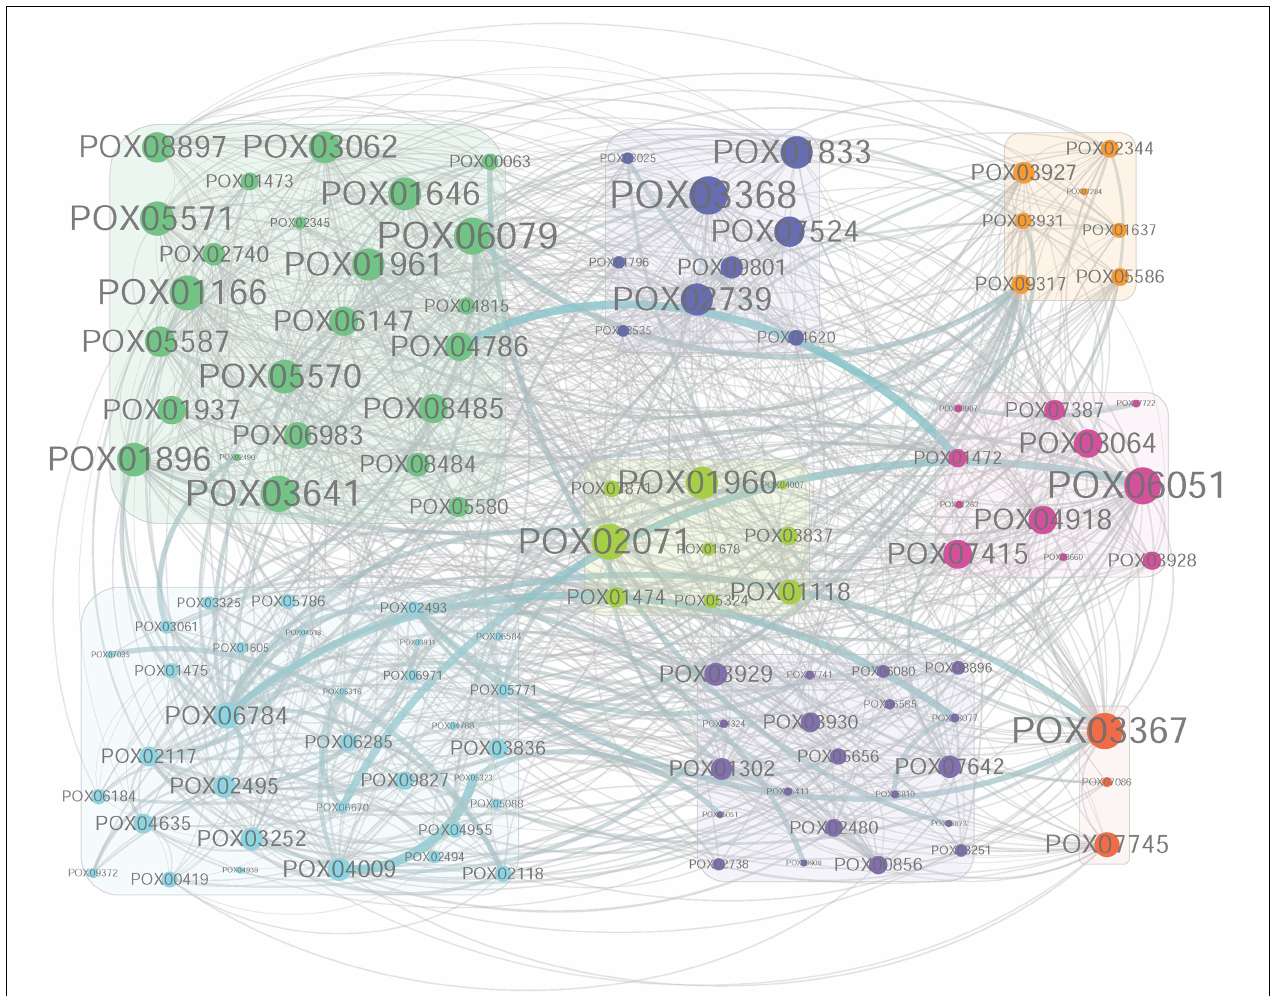
FIGURE 11 | Co-expression network of the highly connected genes in module MEivory. The co-expression network of genes in MEivory was constructed using Cytoscape 3.6.1 software. This network only shows the genes having correlation coefficients greater than 0.4. Cycle size indicates the number of connected genes. Green, CWDEs; Blue, the remaining CAZymes; Light-green, TFs; Dark-orange, proteins involved in protein homeostasis; Orange, other annotated proteins; Pink, putative transporters; Light-blue, hypothetical proteins; Purple,